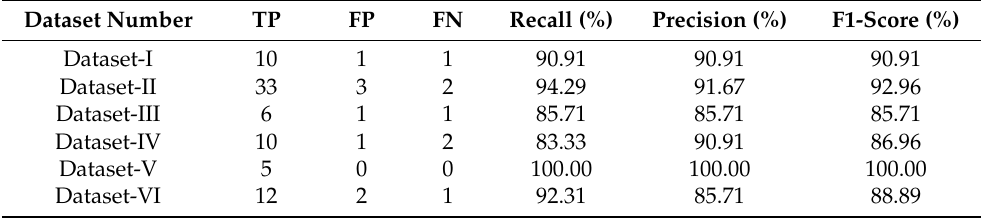
Table 2. Detection accuracy of telegraph poles.